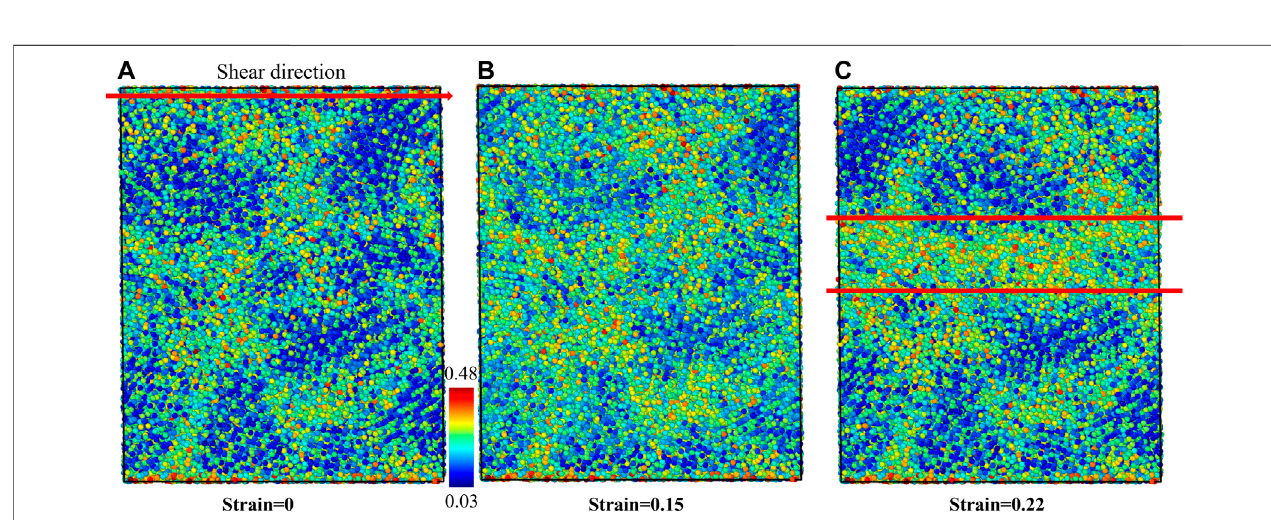
FIGURE 5 | The structural changes of G-phase under shear deformation characterized using OP-8 order parameter. (A) The intact structure, (B) the structure at 0.15 shear strain before the initiation ofshear band, and (C) the structure at 0.22 strain after forming the shear band. The shear band is displayed between two solid red lines at (C)